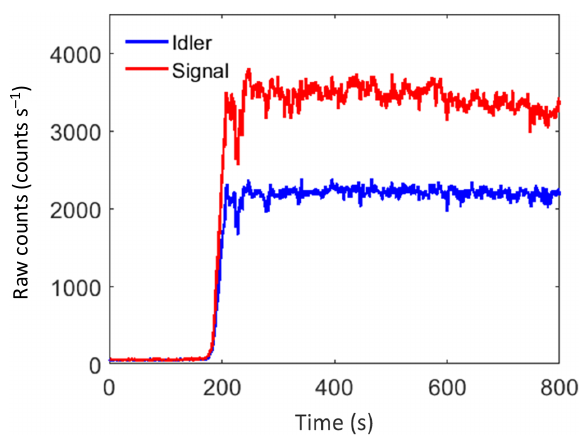
FIG. 7. An example singles scan for an on-chip power of − 15.14 dBm (30.6 μ W). The scan begins with the laser set to an off-resonance wavelength. The laser is then swept to the resonance wavelength, reaching the resonance wavelength at approximately 200 s. The laser is held at this wavelength for 10 min to allow for the average singles rate to be determined.